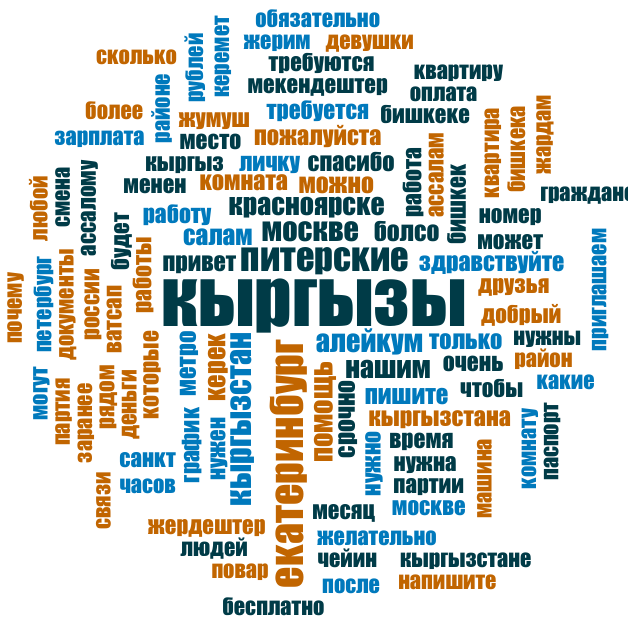
Figure 2. VKontakte Groups: Word Frequency in Posts and Comments.